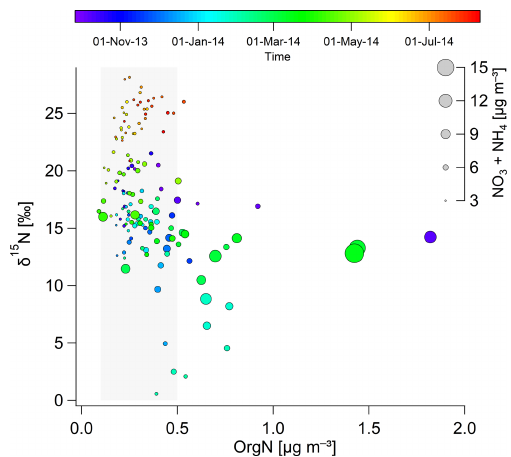
Figure 5. Relationships of δ 15 N of TN vs. OrgN concentrations. The larger circles indicate higher sums of NO − tions. The color scale reflects the time of sample collection, and the highlighted portion is a concentration range between 0.1 and 0.5µgm − 3 .